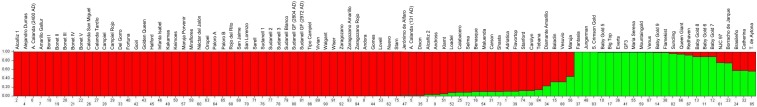
Population structure at K = 2 for the 94 peach/nectarine cultivars analyzed in this study.